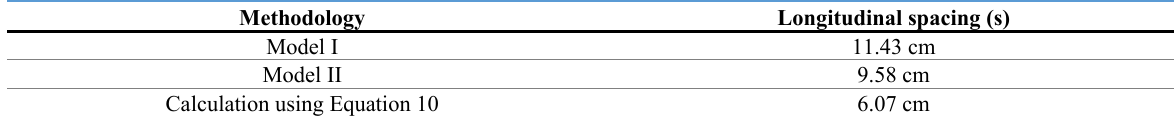
Table 1. Longitudinal spacing of transverse reinforcement, for 6.30 mm diameter